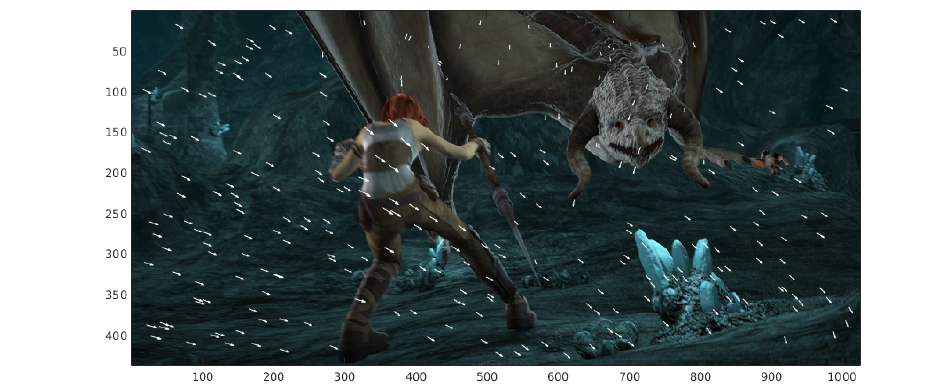
Figure 3. Correspondences of patches located randomly in the reference